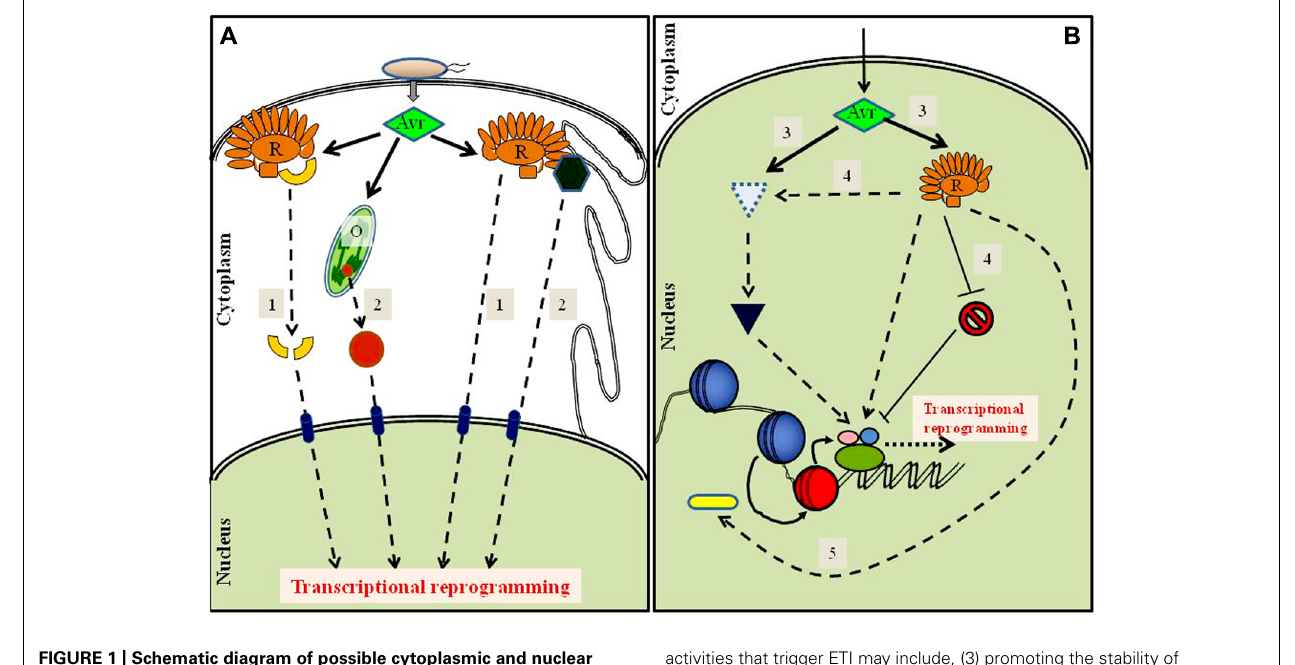
FIGURE 1 | Schematic diagram of possible cytoplasmic and nuclear routes to transcriptome reprogramming by an activated resistance protein. Detection of avirulence effector (Avr) presence or activities by a cognate resistance protein (R) may drive nuclear-directed signaling through multiple processes. (A) The cytoplasmic events may include, (1) direct nuclear translocation of effector-modified virulence targets or of the activated resistance protein itself, or (2) nuclear enrichment of a transcription-modulating protein sequestered in an organelle (O) or tethered to a membrane (e.g., ER). (B) Nuclear-targeted